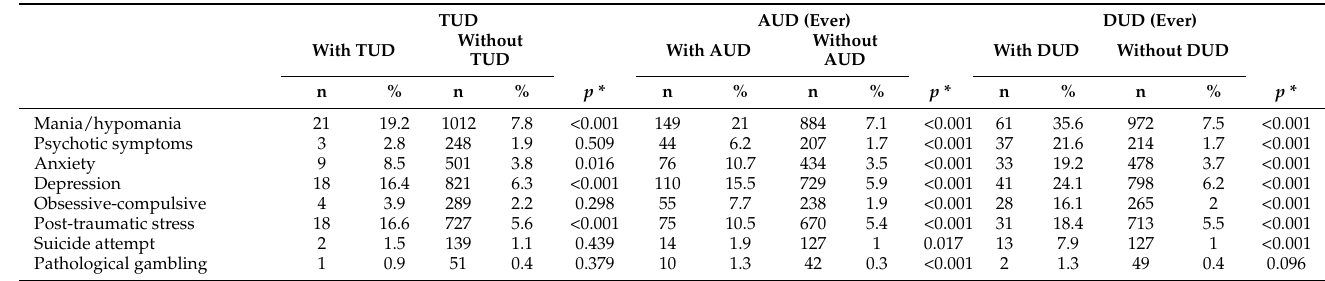
Table 2. Presence of mental illness symptomatology and SUD on tobacco, alcohol, and